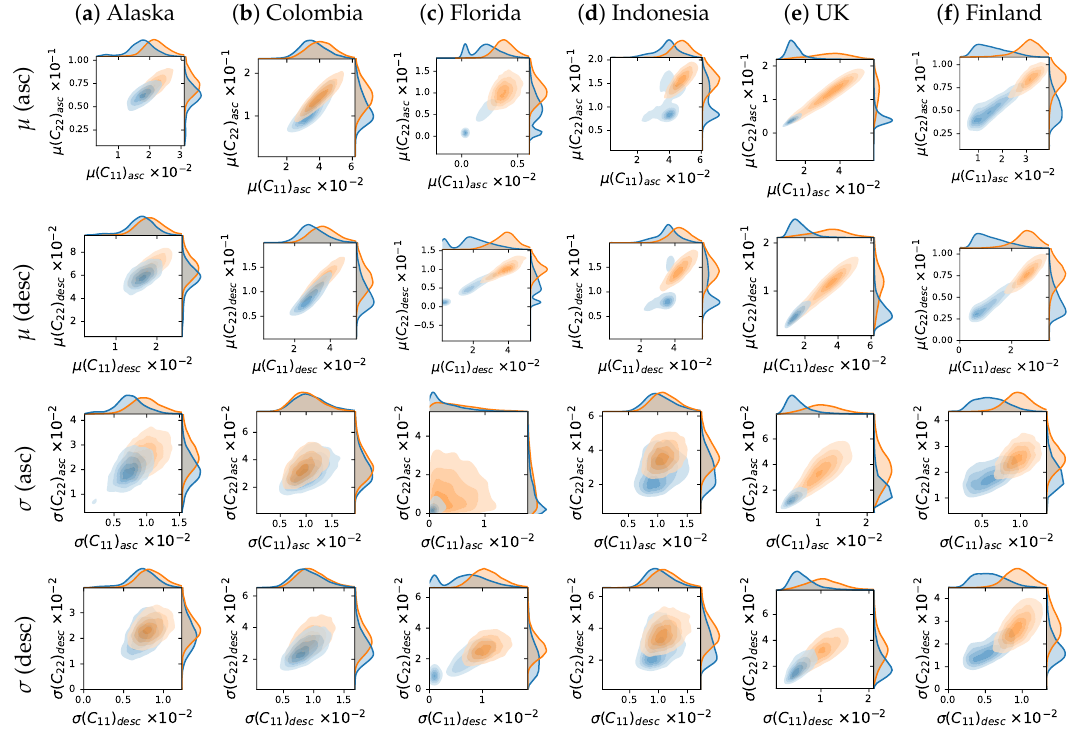
Figure 5. The subplots in this figure show the pairwise distributions of the annual mean and standard deviation of C 11 and C 22 , for ascending and descending orbits. The distributions of forest pixels are shown in orange, non-forest in blue. Darker shades indicate a higher observation density.